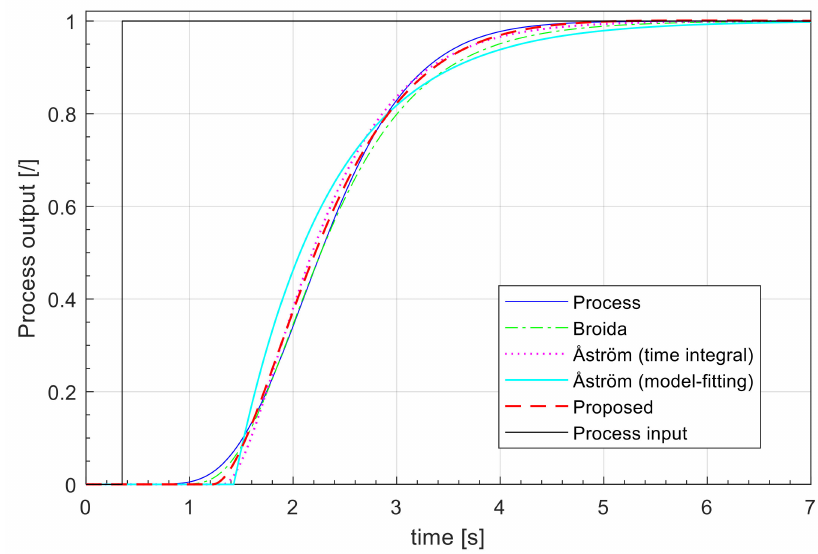
Figure 10. The step-change responses for process G P2 .